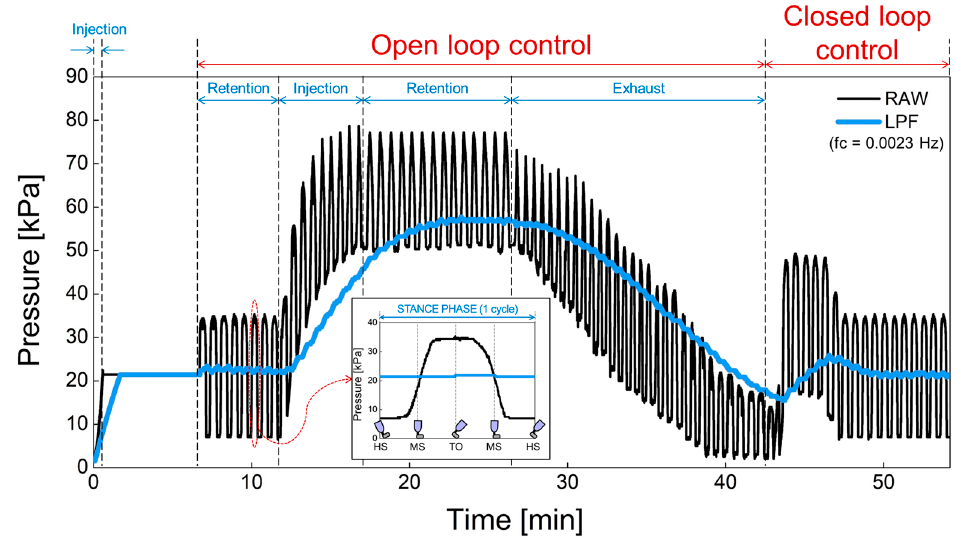
Figure 16. The open and closed loop control in a prosthesis with an air bladder inserted.